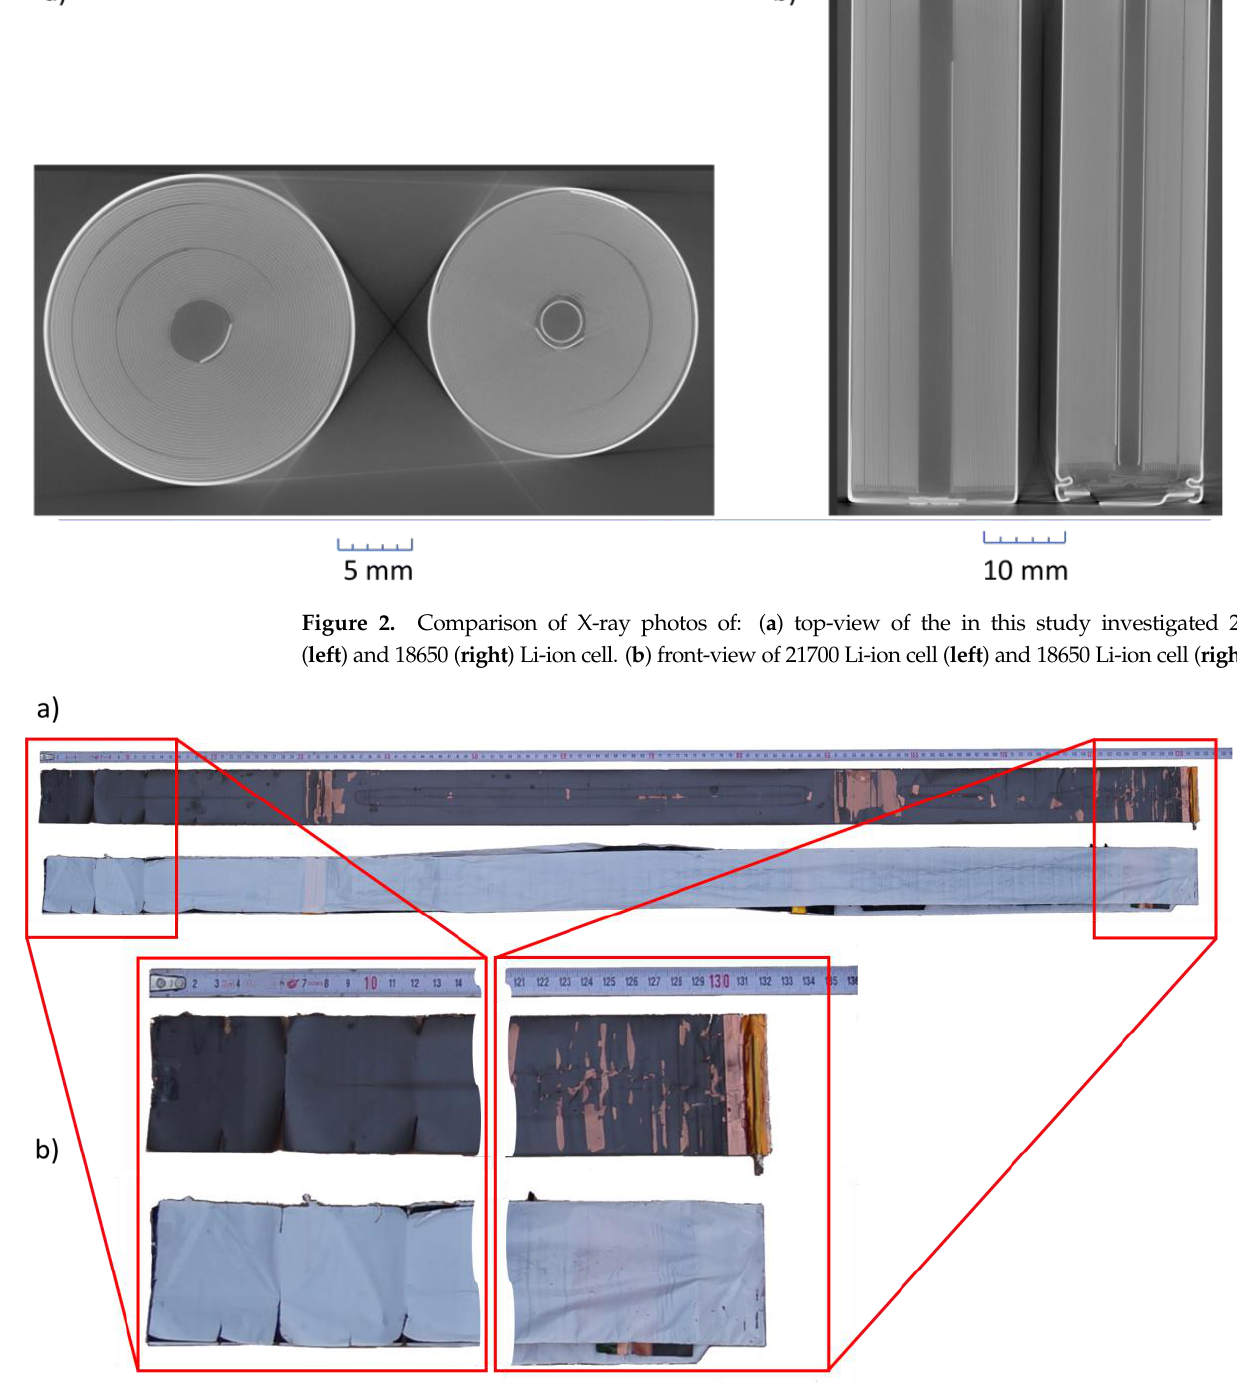
Showing the entire length ( a ) and zoomed view ( b ) at both ends.